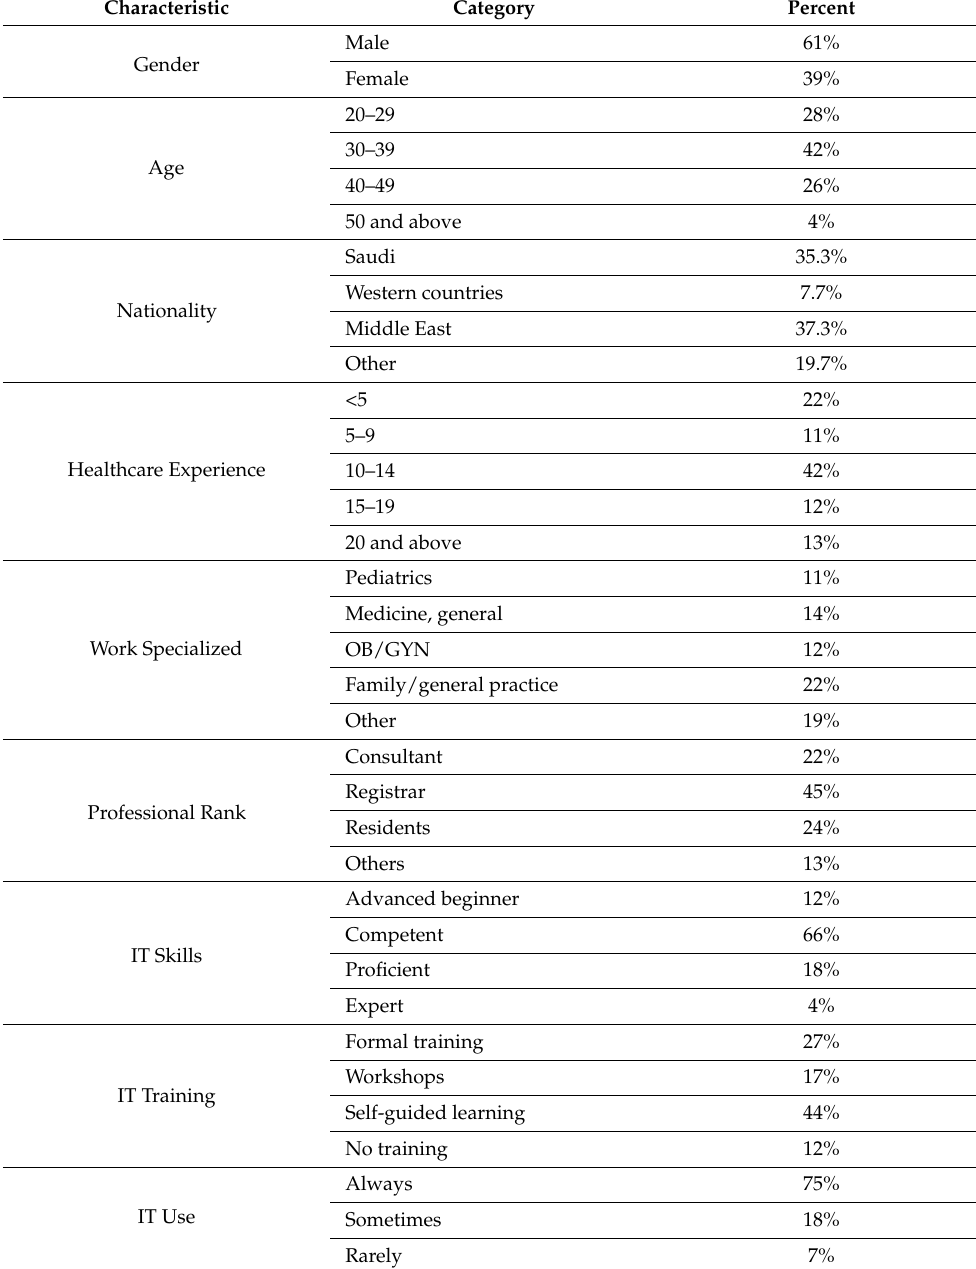
Table 3. Participants’ demographic